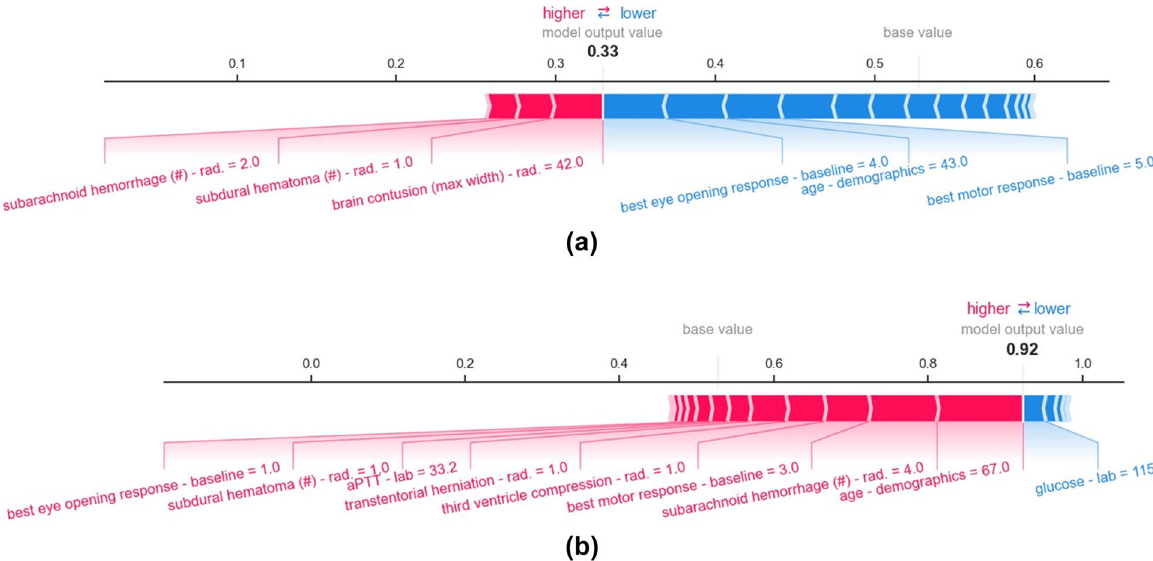
Fig. 4 SHAP force plots corresponding to predicted risk scores for individuals. The base value corresponds to the average model output over the training set and is the proportion of the training samples belonging to the class GOSE 1 – 4. Red and blue arrows, respectively, depict the amount of positive and negative contribution of variables to the predicted risk score. The model output value corresponds to the predicted risk score. For example, the patient shown in plot a has a 33% probability of experiencing GOSE 1 – 4, while the patient shown in b has a 92% probability of experiencing GOSE 1 – 4. Variable types are denoted as rad : radiology report and lab : laboratory